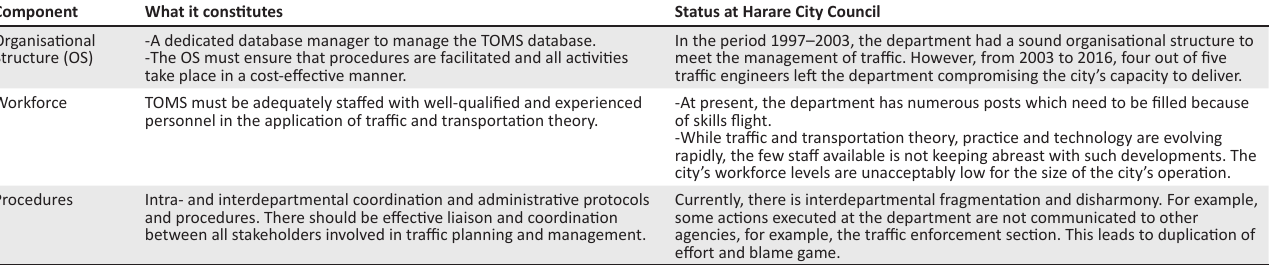
TABLE 5: Status of Traffic Operations Management System components in Harare City Council, Traffic and Transportation Department.